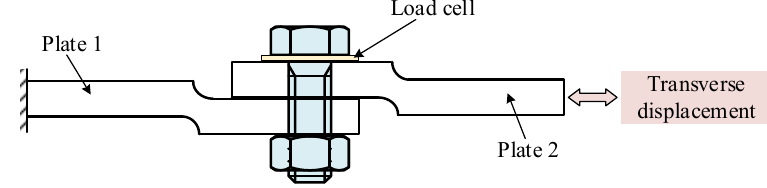
Figure 8. Bolted lap joint described in Ref. [49].